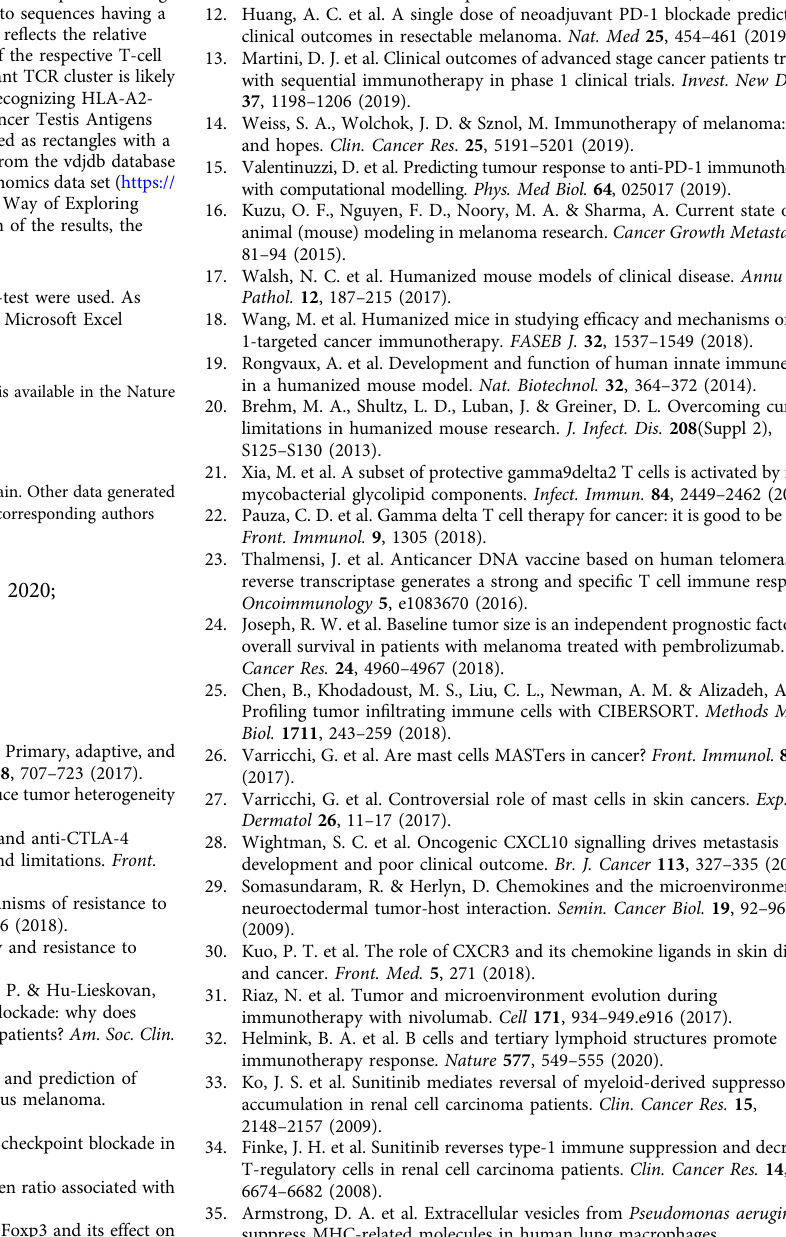
Fig. 6 Complete regression of tumors after a combination of sunitinib and anti-PD therapy. a Using an independent batch of Hu-mice, established tumors (A375) (details as in Fig. 2g, h; n = 5/group) were treated with sunitinib (20 mg/kg) daily by oral gavage and after 72 h, anti-PD-1 therapy (10 mg/ kg) was given weekly for a total of 6 injections. Complete tumor regression was observed in presence of combination therapy (black inverted triangle; p = 0.0001; 2nd panel), while sunitinib alone (gray circles), anti-PD-1 alone (blue line, closed circles) or control IgG (magenta; open circles) did not have any effect of tumor growth. We observed similar results when drug imatinib (50 mg/kg; daily by oral gavage) was used in combination with anti-PD-1 (brown line, closed circles; p = 0.0282; n = 7; 3rd panel from the bottom). Imatinib alone had no effect on tumor growth. Cediranib (6 mg/kg; daily by oral gavage) either alone or in combination with anti-PD-1 antibody was unable to shrink the tumors ( n = 3 per group; bottom panel). Data are presented as mean values ± SD. A one-sided paired t -test was used for analysis when p -values are provided. b Survival curve from the above-treated mice indicates signi fi cant ( p = 0.0013 as determined by the log-ranked test) survival advantage of tumor-bearing Hu-mice that received combination therapy of sunitinib and anti- PD-1 group when compared to sunitinib alone (gray), or anti-PD-1 alone (dark blue) or control IgG (magenta) groups . c , d Depletion of mast cells in spleen in sunitinib treated mice (bottom [1000] μ m left and right panels [100] μ m) when compared to control mice (top left [1000] μ m and right panels [100] μ m panel). Histology staining ( c , d ) was con fi rmed in repeat experiments (2×). e Schema of mast cell-induced resistance mechanism to anti-PD-1. Source data are provided as a Source Data